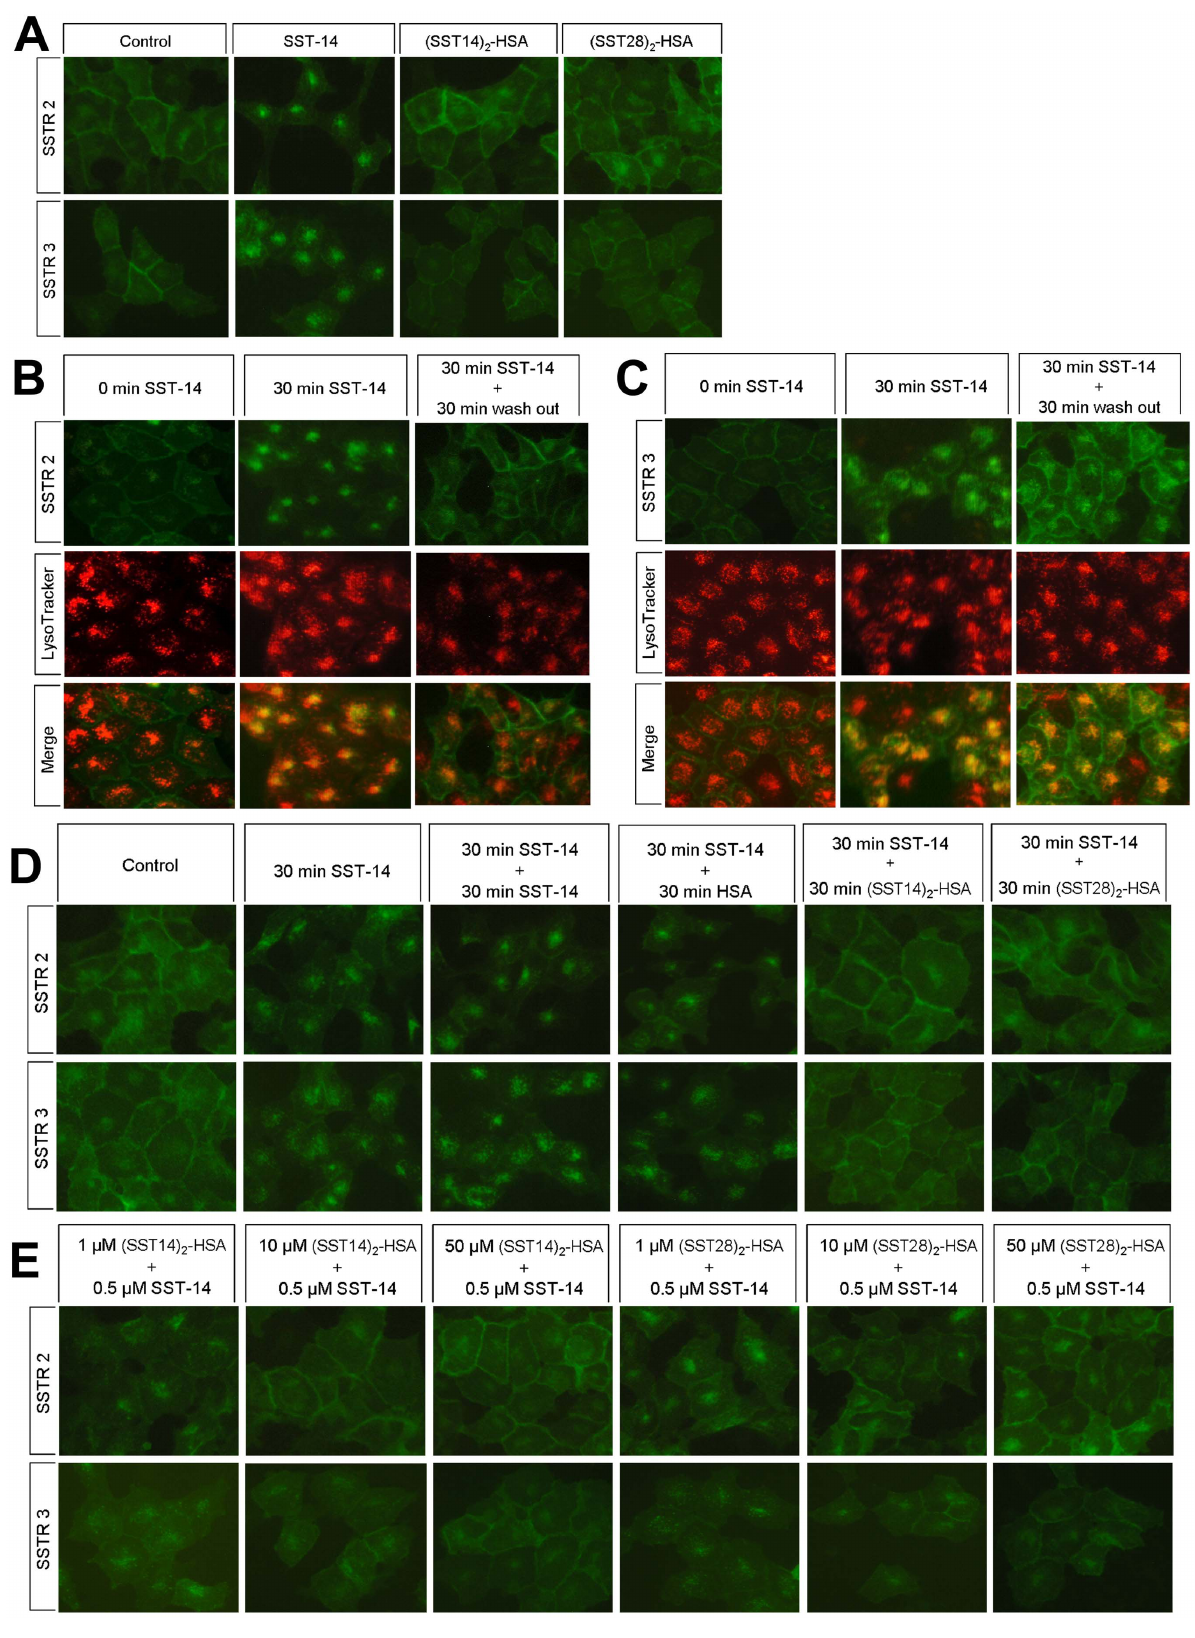
Figure 3. Regulation of somatostatin-HSA fusion proteins to receptors internalization and recycling in SSTR2- and SSTR3- expressing cells. (A) Comparison of agonist-induced endocytosis of SSTR2 and SSTR3. HEK 293 cells stably expressing SSTR2- or SSTR3-EGFP were